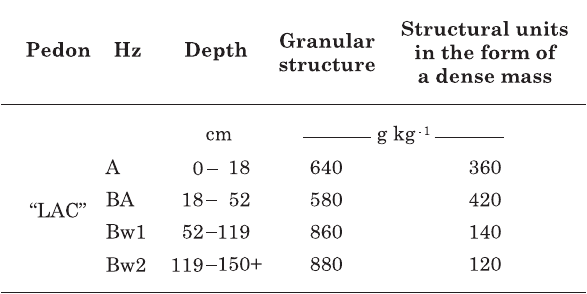
Table 2. Characterization of "LAC" profile